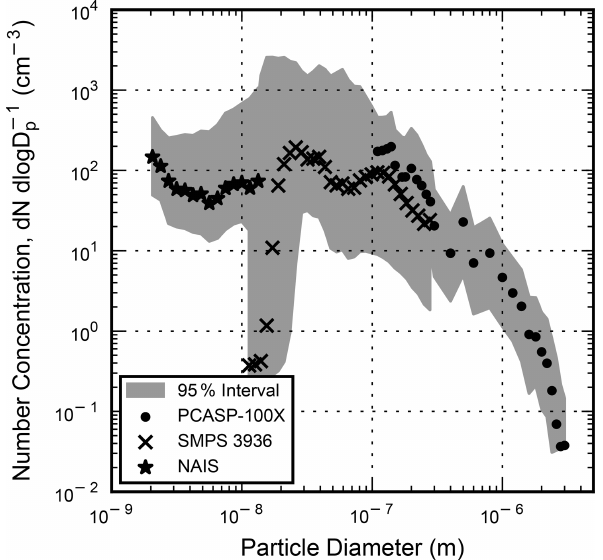
Figure 17. The median particle size distribution measured by the PCASP-100X, SMPS3936, and NAIS across the entire voyage. Note that the spectrum above 3µm is not shown and was not evalu- ated in this